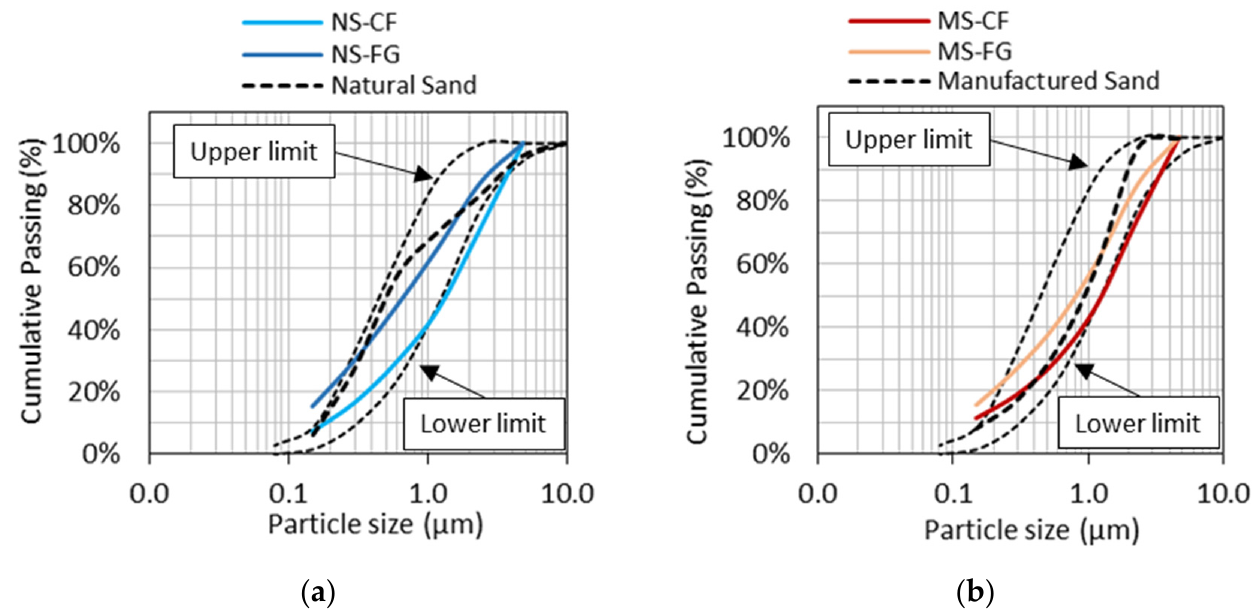
Figure 2. Particle size distribution curves for FRCA derived from natural ( a ) and manufactured sand ( b ) companion conventional concrete.